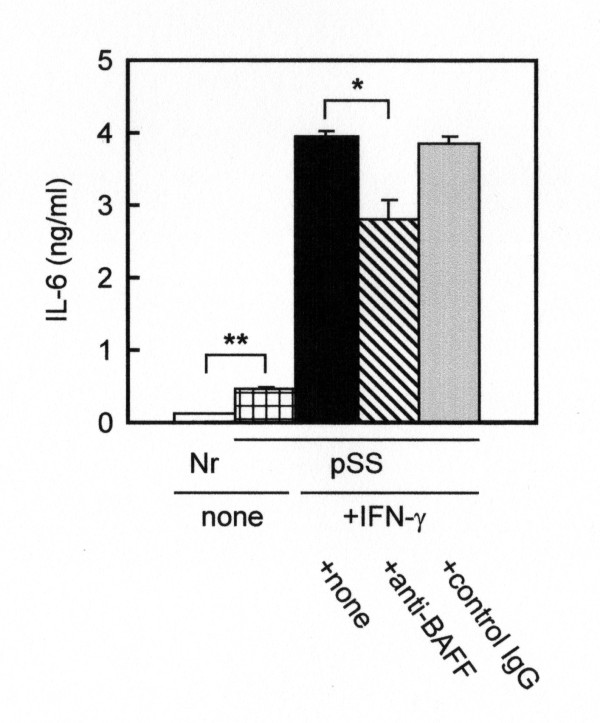
Production of IL-6 by peripheral monocytes stimulated with IFN-γ. Monocytes (2.5 × 105/ml) prepared from normal individuals (Nr) (open column) and primary Sjögren's syndrome (pSS) patients (checkerboard column) were cultured for 96 hours without stimulation. pSS monocytes were similarly cultured in the presence of 200 ng/ml of recombinant human IFN-γ (closed, hatched and gray columns), and simultaneously exposed to none (closed column), an anti-BAFF antibody (10 μg/ml; hatched column) or a control IgG (10 μg/ml; gray column). The amounts of IL-6 in the culture supernatants were measured by sandwich ELISA. BAFF = B-cell-activating factor of the TNF family; IgG = immunoglobulin G. Data represent means ± SEM. *P < 0.05 and **P < 0.01.